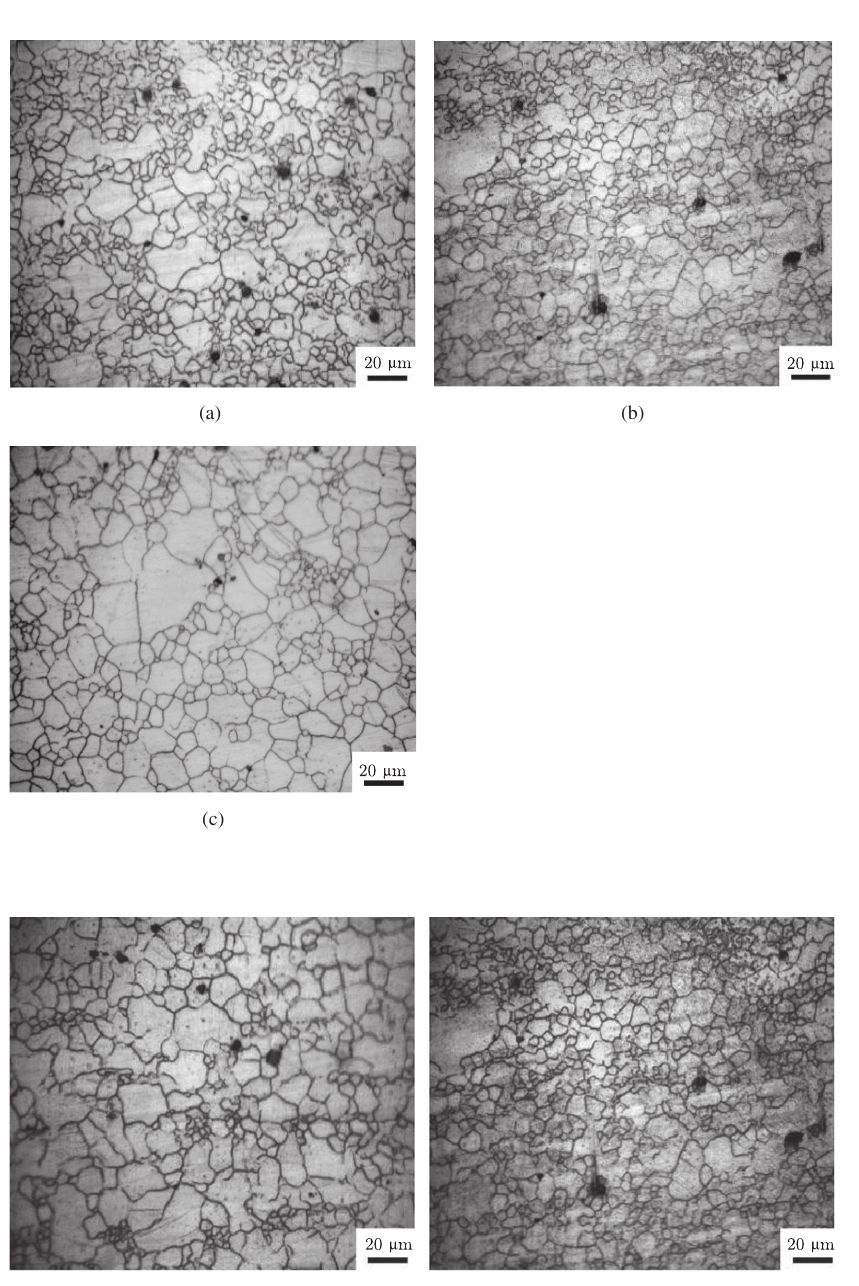
Figure 3: Microstructure of bars at the billet temperature of 400 ℃ : (a) direct extrusion and (b) ES